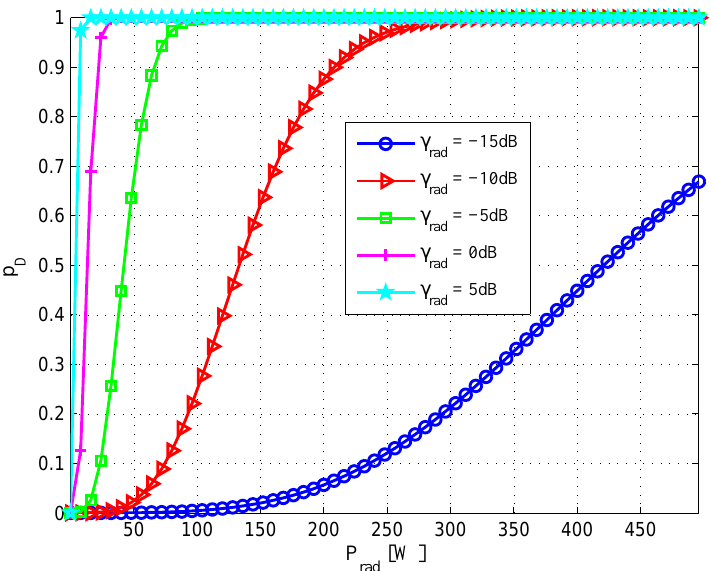
Figure 2. Probability of detection p D versus transmit power for radar waveform P rad with different γ rad ( δ FA = 10 − 6